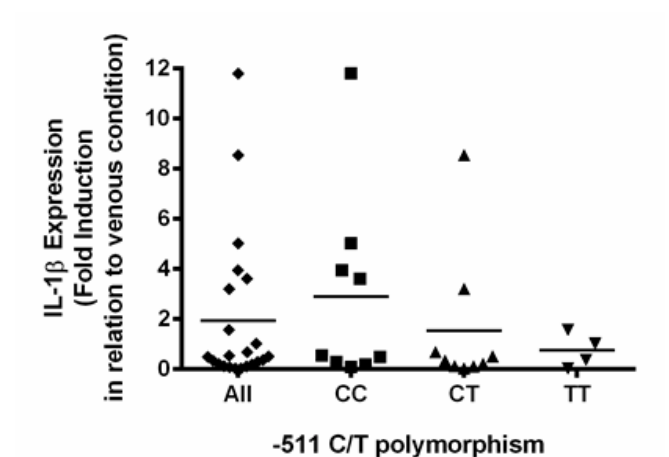
Figure 2. ( A ) Semi-quantitative analyses of IL-1 β in a human saphenous vein graft obtained from autopsy. Immunohistochemistry for IL-1 β was performed, and the positive-stained area was normalized by the total vessel area. Samples were grouped as early (1–5 days, N = 15) and late (1–4 years, N = 11) vein grafts. Fresh isolated human saphenous veins (N = 10) were used for reference (dashed line). * indicates p < 0.05. ( B ) Expression of IL-1 β in arterialized human saphenous vein and evaluation of the influence of -511C / T IL-1 β polymorphism. Real time RT-PCR for IL-1 β was performed in human saphenous vein cultured in venous or arterial conditions. The results were normalized by 28S ribosomal RNA. Each dot represents the fold induction of the arterial sample compared with the venous sample. The graphic shows the results of all samples analyzed ( (cid:7) ) and the sample stratified by -511C / T IL-1